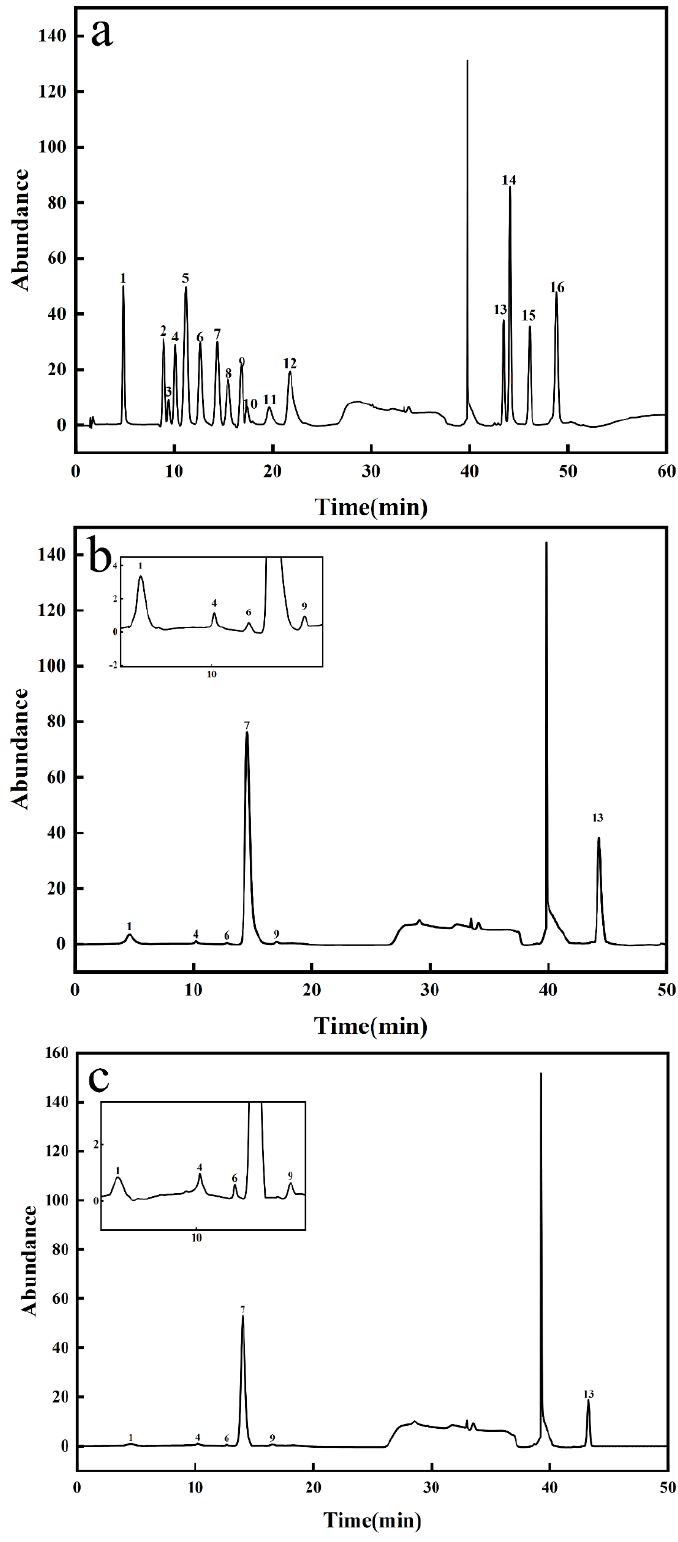
Figure 7. Monosaccharide composition. ( a ) HPIEC of monosaccharide standards; ( b ) HPIEC of AP; ( c ) HPIEC of SAP. Peaks: (1) fucose; (2) galactosamine; (3) rhamnose; (4) arabinose; (5) glucosamine; (6) galactose; (7) glucose; (8) glucosamine; (9) xylose; (10) mannose; (11) fructose; (12) ribose; (13) galac- turonic acid; (14) guluronic acid; (15) glucuronic acid; (16) mannose